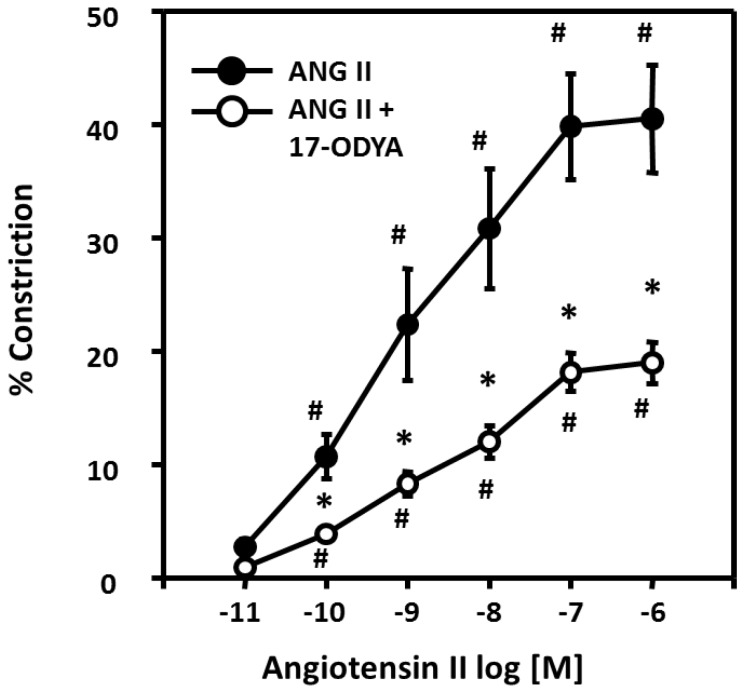
Effects of 20-HETE on vasoconstrictor responses to ANG II in renal microvessels.Concentration response curves for the vasoconstrictor response to ANG II (10-11 to 10-6 M) in pressurized renal microvessels with the endothelium removed (N=5) are presented before and after addition of 17-ODYA (10-5 M). 17-ODYA an inhibitor of the formation of 20-HETE had no significant effect on the EC50 but it reduced the maximal response to ANG II by 50%. # indicates a significant difference from the value at the lowest concentration of ANG II concentration (10-11 M). * indicates a significant difference from the corresponding value prior to treatment of 17-ODYA (10-5 M).